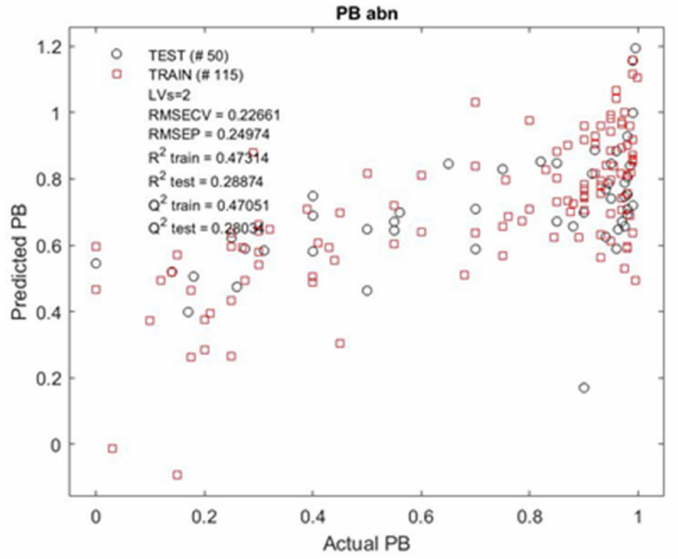
Figure A1. Actual versus predicted PB abn values using PLS modelling and 23 molecular descriptors including NP TLC data. LVs = latent variables, RMSE CV = root-mean-square error of cross-validation, RMSE P = root-mean-square error of prediction, R 2 train/test = coefficient of determination for train/test set models, Q 2 train/test = coefficient of determination for the cross-validated